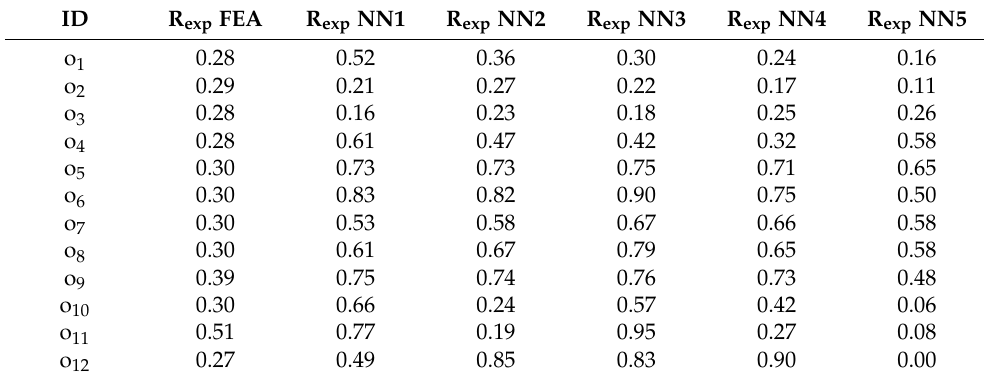
Table 5. Neural network generalization performance compared to FEA results.